Question: Sum up the contents of this chart in one sentence.
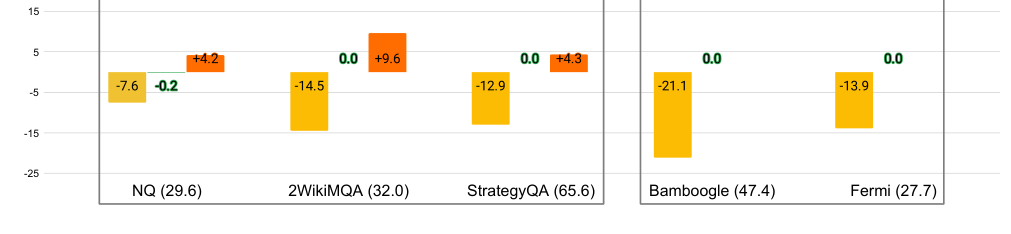
Answer: Results with low-rank (top) and random retrieval (bottom). Models are similar to those in Fig.4. Performance significantly decreases for the prompted model in all settings, while it is maintained when using NLI models. Our finetuned SA-RetRobust is best performing in all settings. We show that SA-RetRobust learned to both ignore irrelevant context and better utilize relevant context by comparing to an ablated model without retrieval in §4.